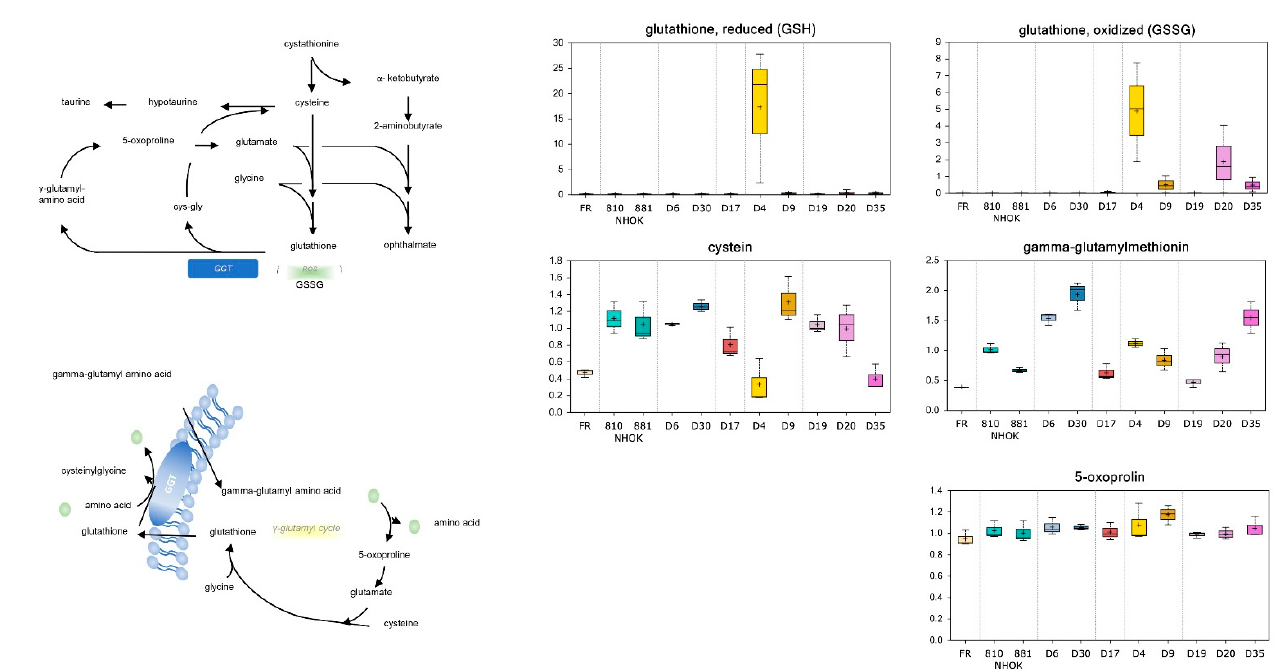
Figure 6. Alterations of the glutathione metabolism in PPOL and normal keratinocytes. The symbols are the same as for Figure 3. Data represents the means of three independent experiments +/- standard deviation. For statistical analyses see Supplementary Tables S3–S7. GGT = Gamma glutamyl transferase; GSH = reduced glutathione; and CSSG = oxidized glutathione.